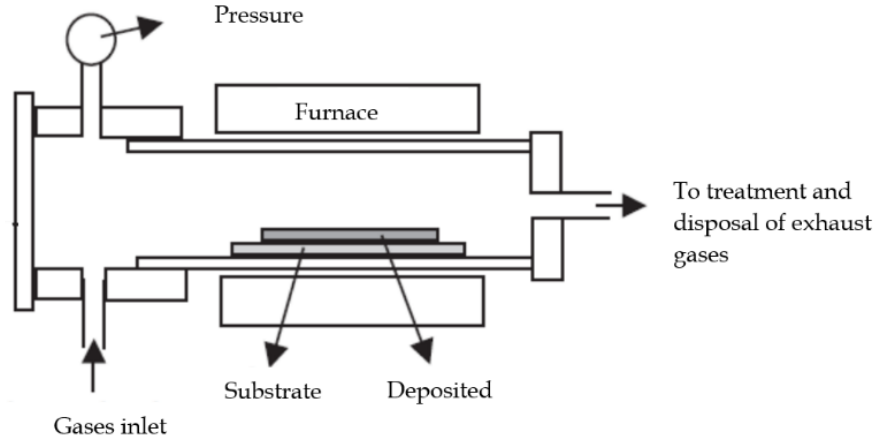
Figure 5. Schematic representation of CVD technique [42]. Reprinted with permission from [42]; 2016 Research India Publications.